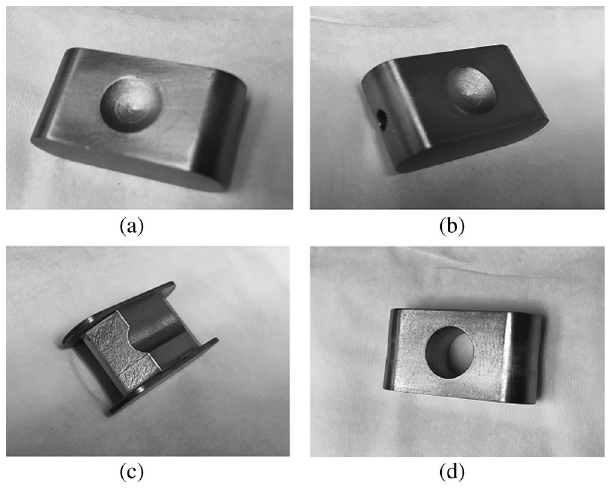
FIG. 20. Noise ratio as a function of pressure for different cathodes. Arc current is 15 A and extraction voltage is − 35